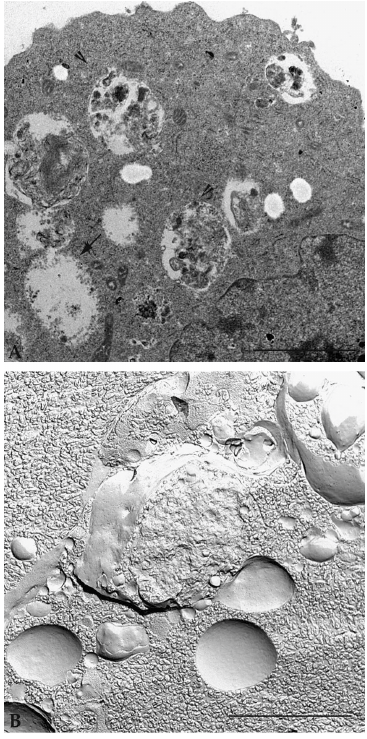
Figure 6. Transmission electron microscopic observation of autophagic tumor cells, after treatment with natural compound. ( A ) Observation of ultrathin sections shows vacuoles at different stages of maturation: empty vacuoles (arrow), vacuoles with digested and strongly electrondensated materials (arrowhead); ( B ) Observation of sample prepared by freezing technique shows vacuoles with multilayer membrane. Scale bar: 2 µ